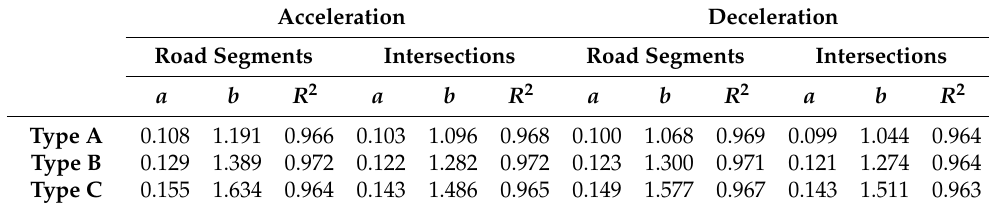
Table 8. The acceleration and deceleration distribution fitting parameters.